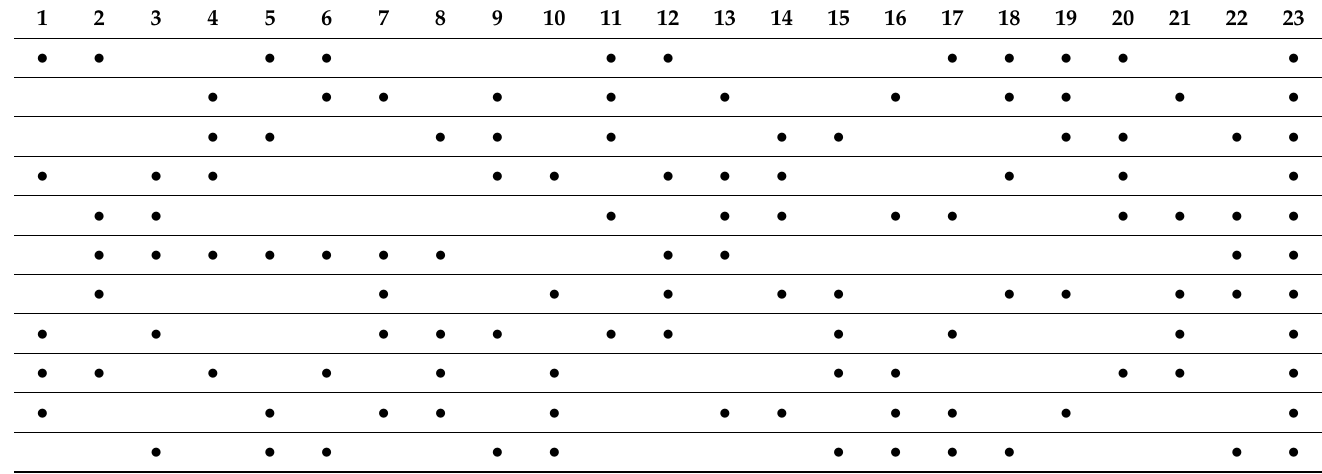
Table 3. A (11,22,5,10,4)—block